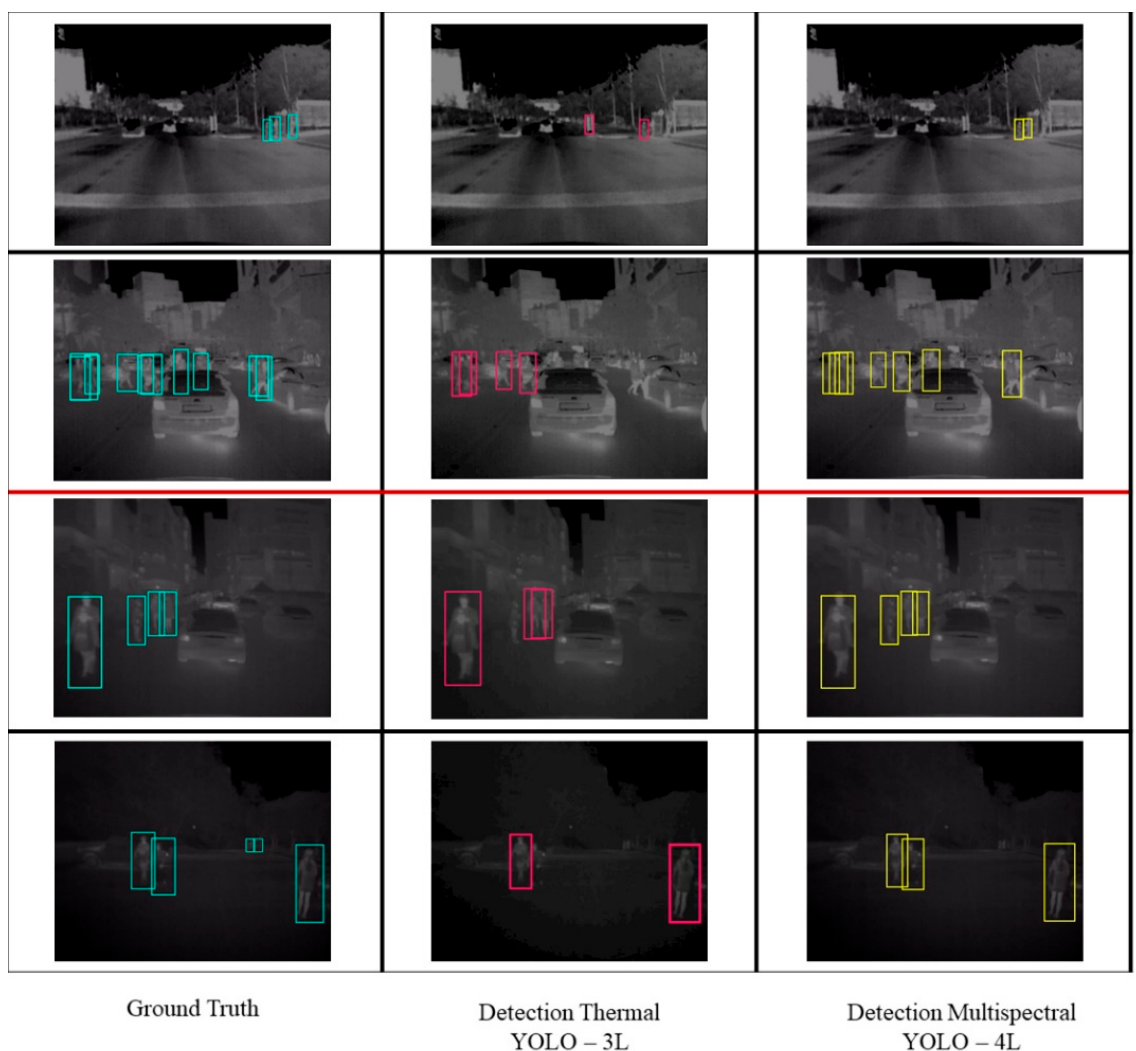
Figure 6. Ground truth and detection examples using the thermal-based of YOLO-3L model and the multispectral-based of YOLO-4L model.